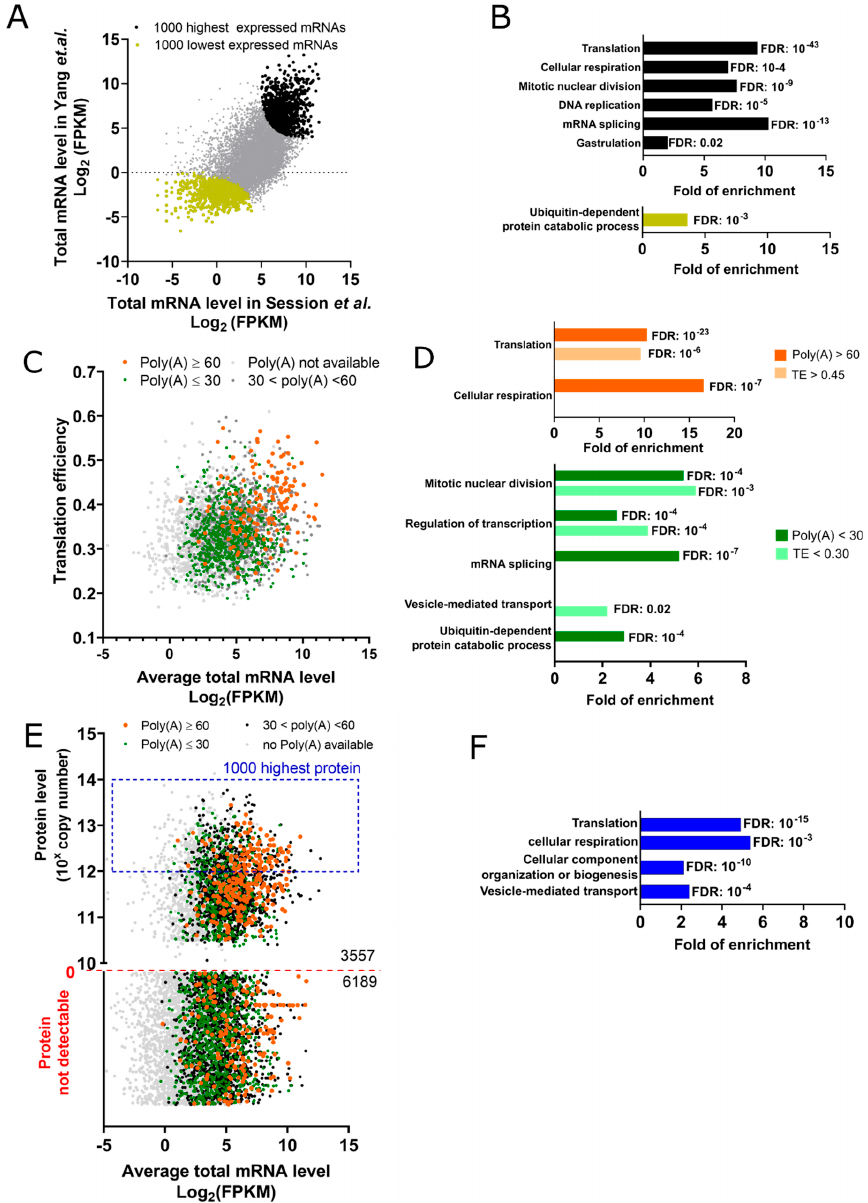
Figure 3. Genome-wide analysis of the fully-grown prophase-arrested oocytes. ( A ) The expression level of each mRNA quantified using two independent published datasets [37,72]. Each transcript is ranked in the two databases according to its level of expression. The average rank is used to highlight the 1000 transcripts with either the lowest (yellow) or the highest level of expression (black). ( B ) Gene ontology terms enriched among 1000 highest (black) or 1000 lowest (yellow) expressed transcripts from panel A. ( C ) The translation efficiency (TE) is defined as the fraction of mRNAs recovered in the polysomes divided by the concentration of total mRNAs of each transcript. TE has been correlated with its total level [37,72]. The extent of the poly(A) tail length has been color-coded: black (30 to 60 nt), green ( ≤ 30 nt), orange ( ≥ 60 nt), grey (poly(A) length not available). ( D ) Gene ontology terms enriched among the transcripts with poly(A) tail ≥ 60 nucleotides (dark orange) and TE ≥ 0.45 (light orange) or among poly(A) tail ≤ 30 nucleotides (dark green) and TE ≤ 30 (light green) from panel C. ( E ) The expression level of each protein is compared to the level of its mRNA [37,70,72]. The same color code as panel C is applied for the poly(A) length. ( F ) Gene ontology terms enriched among 1000 highest expressed proteins from panel